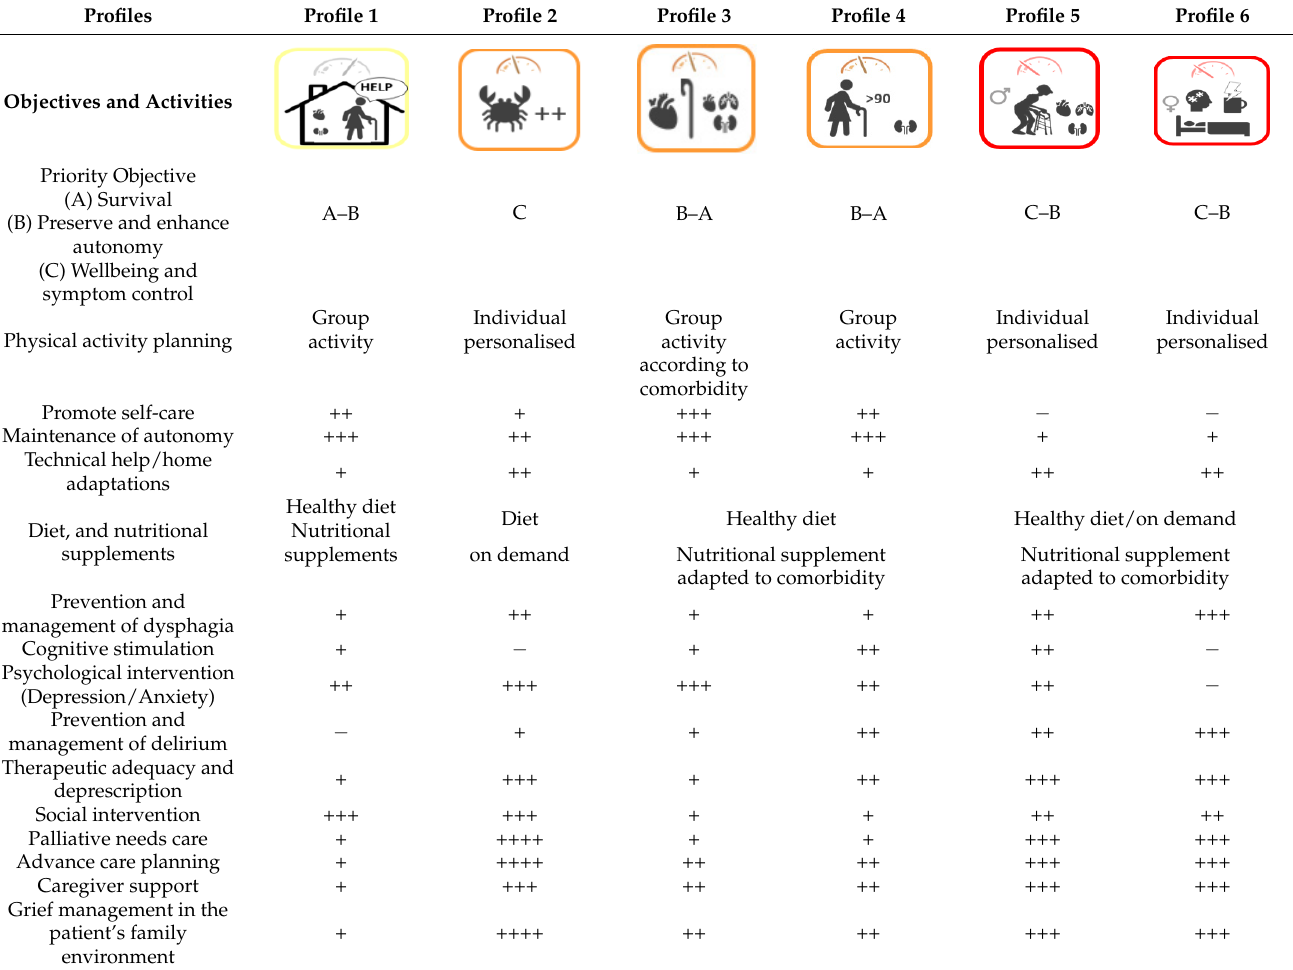
Table A1. Proposal for care objectives and interventions for each six profiles identified. Profiles Profiles